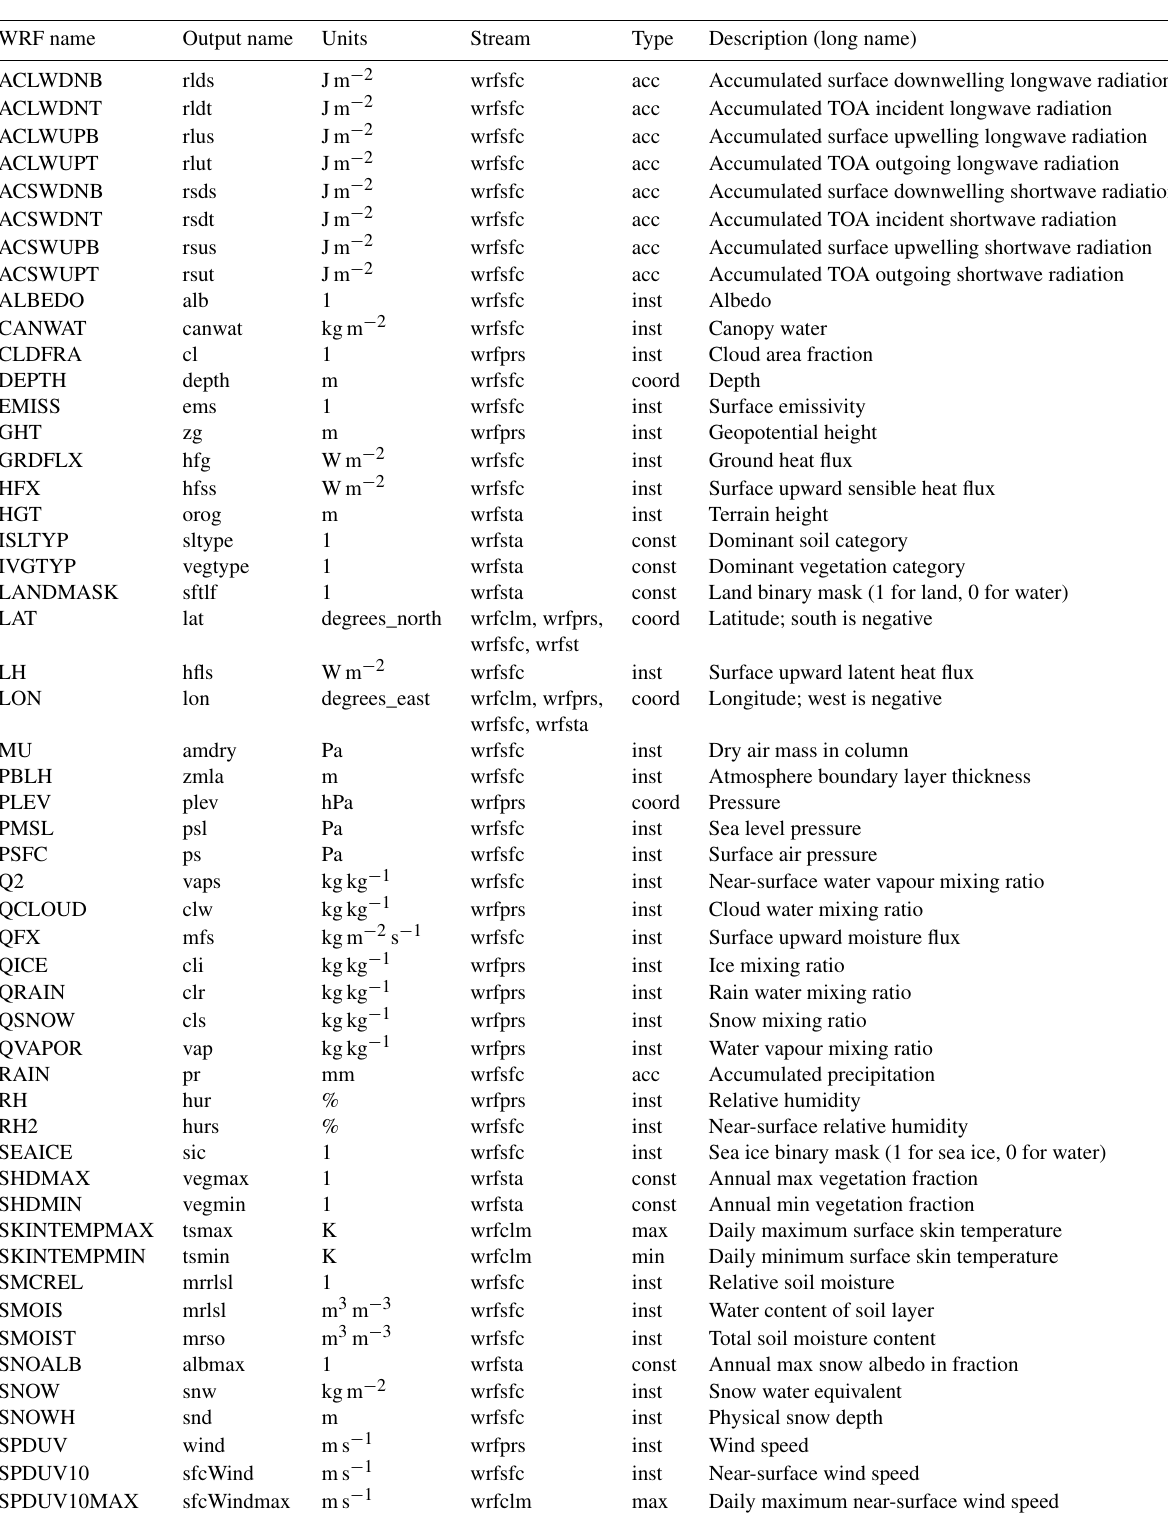
Table A1. List of output variables of the WASCAL WRF climate simulations. The variable types are “acc” (accumulated values), “coord” (coordinate variables), “const” (constant values), “min” (minimum over last output interval), “max” (maximum over last output interval) and “inst” (instantaneous